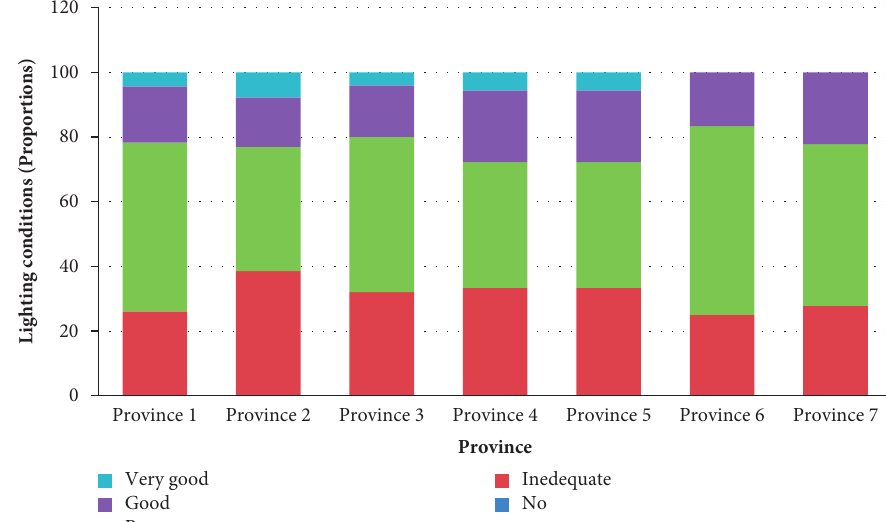
Figure 5: Provincewise lighting conditions in laboratories.